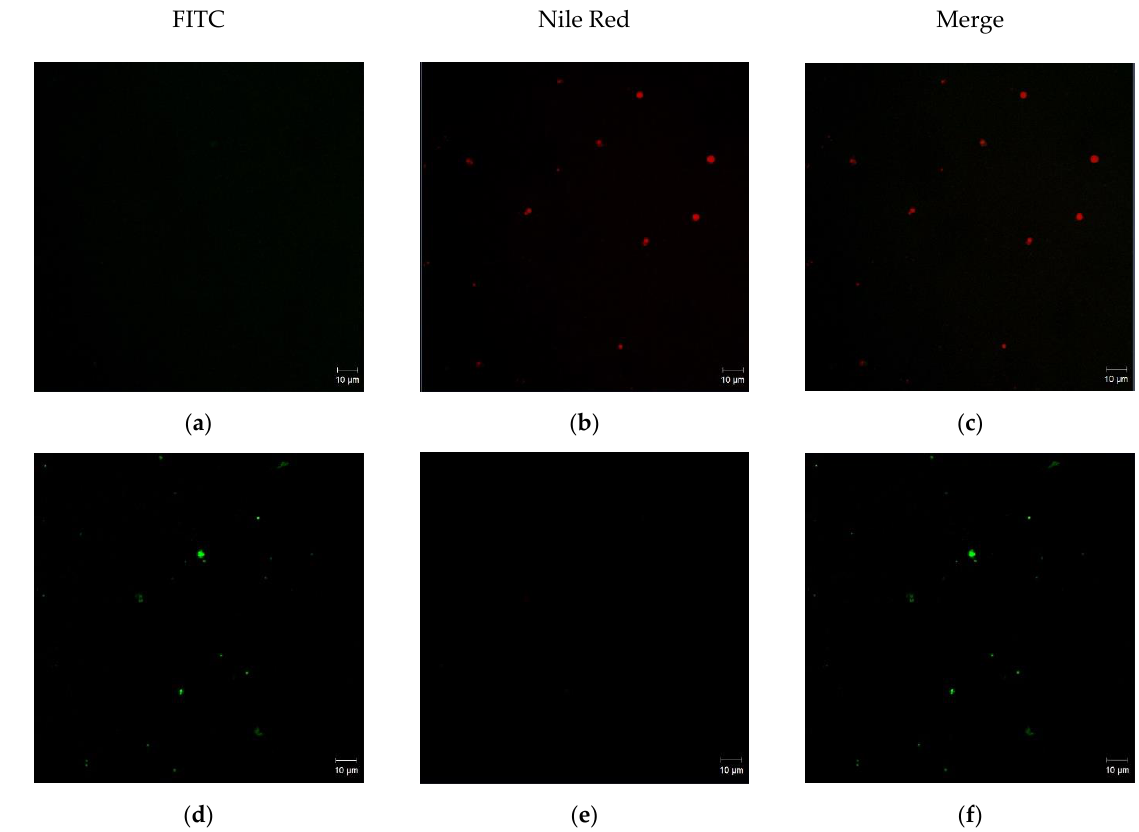
Figure 9. Confocal laser scanning microscopy images of TE-NEs ( a – c ) and WCS-TE-NEs ( d – f ). Nile Red dye shows a red color by binding with lipids and oils in the TE-NEs, whereas FITC shows a green color by binding with proteins and chitosan in the WCS-TE-NEs.